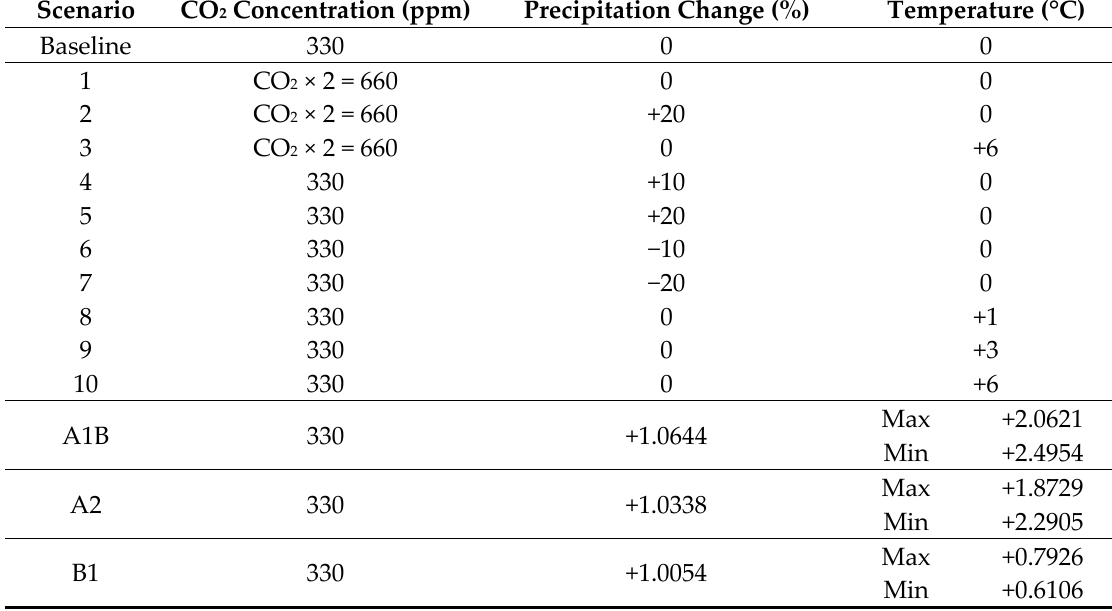
Table 4. Conditions of climate sensitivity scenarios and intergovernmental panel on climate change (IPCC) special report on emissions scenarios relative to the baseline. Scenarios 1–3 are referred to as the CO 2 scenarios, 4–7 as precipitation change scenarios, and 8–10 as temperature increase